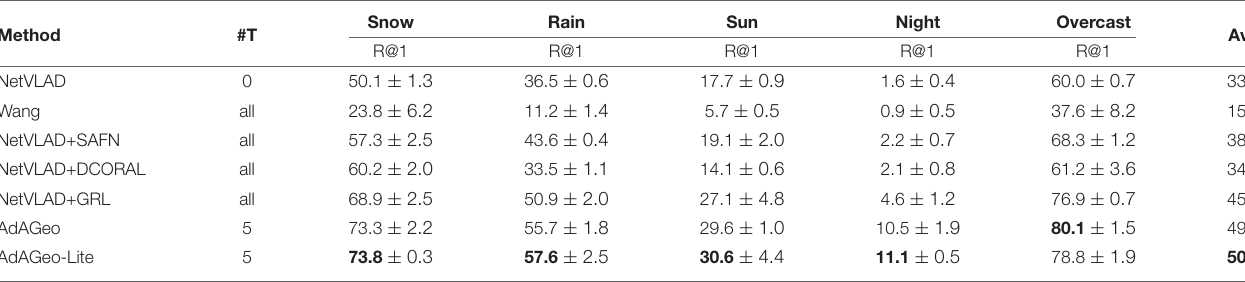
TABLE 3 | Domain adaptation results: comparison between all methods, shown as recall@1 (R@1) on each target domain. Method